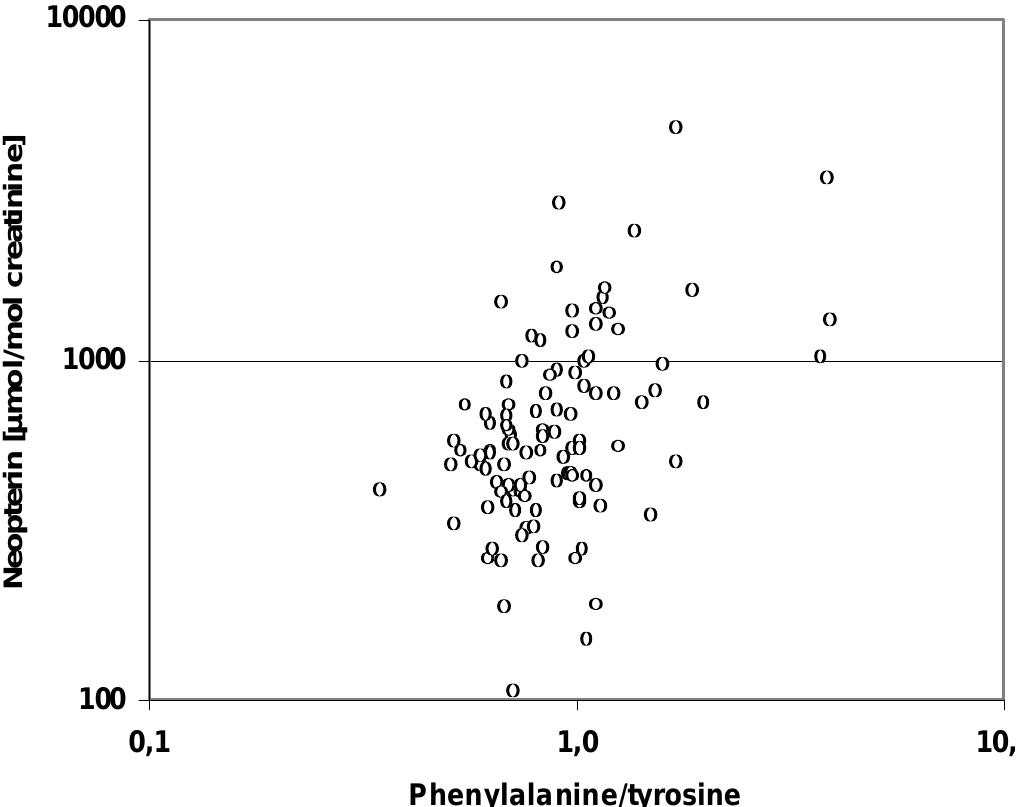
Figure 4. Correlation between phenylalanine to tyrosine ratio and neopterin concentrations in patients with HIV- = 0.392, p < 0.001), adapted from Zangerle et al. 2010 (note: 1 infection (r s